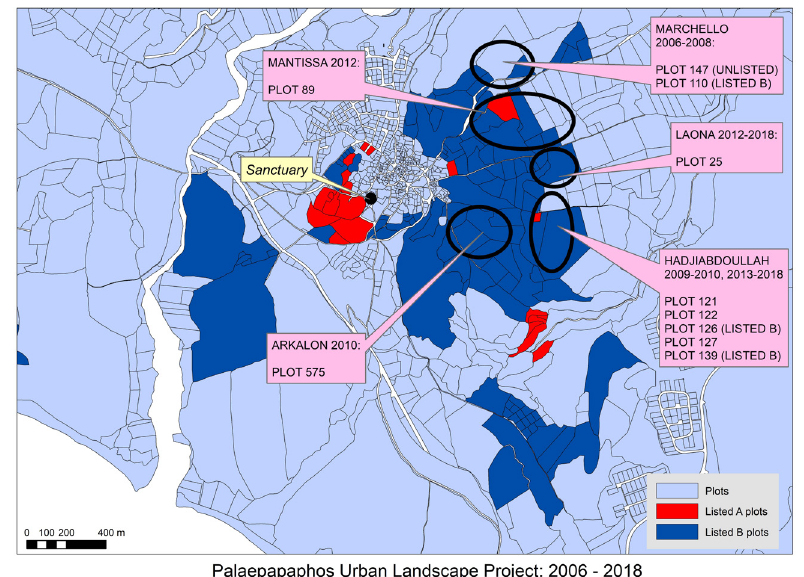
Figure 16. Map showing locations and plots where PULP has conducted excavations since 2006. (PULP + Remote Sensing and